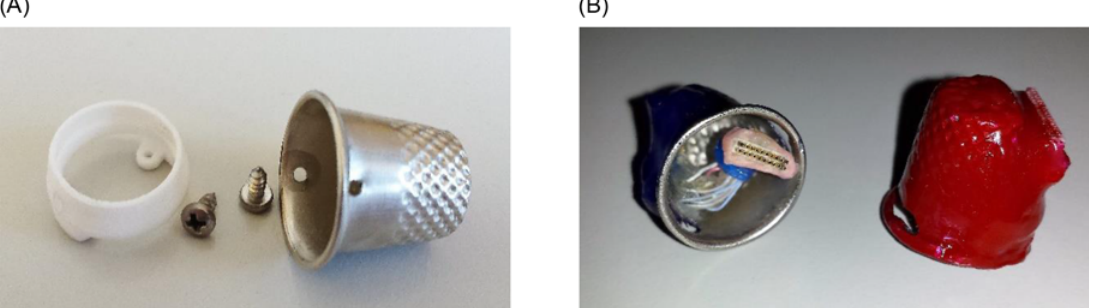
Fig 1. Photographs of headstage socket, and waterproof thimble attachment. A polyamide head-stage socket is shown with its connecting stainless steel thimble and screws, and also a PCB connector which is placed inside during surgery (A). A wireless system attachment was created using electrode connectors, glue, and a sewing thimble